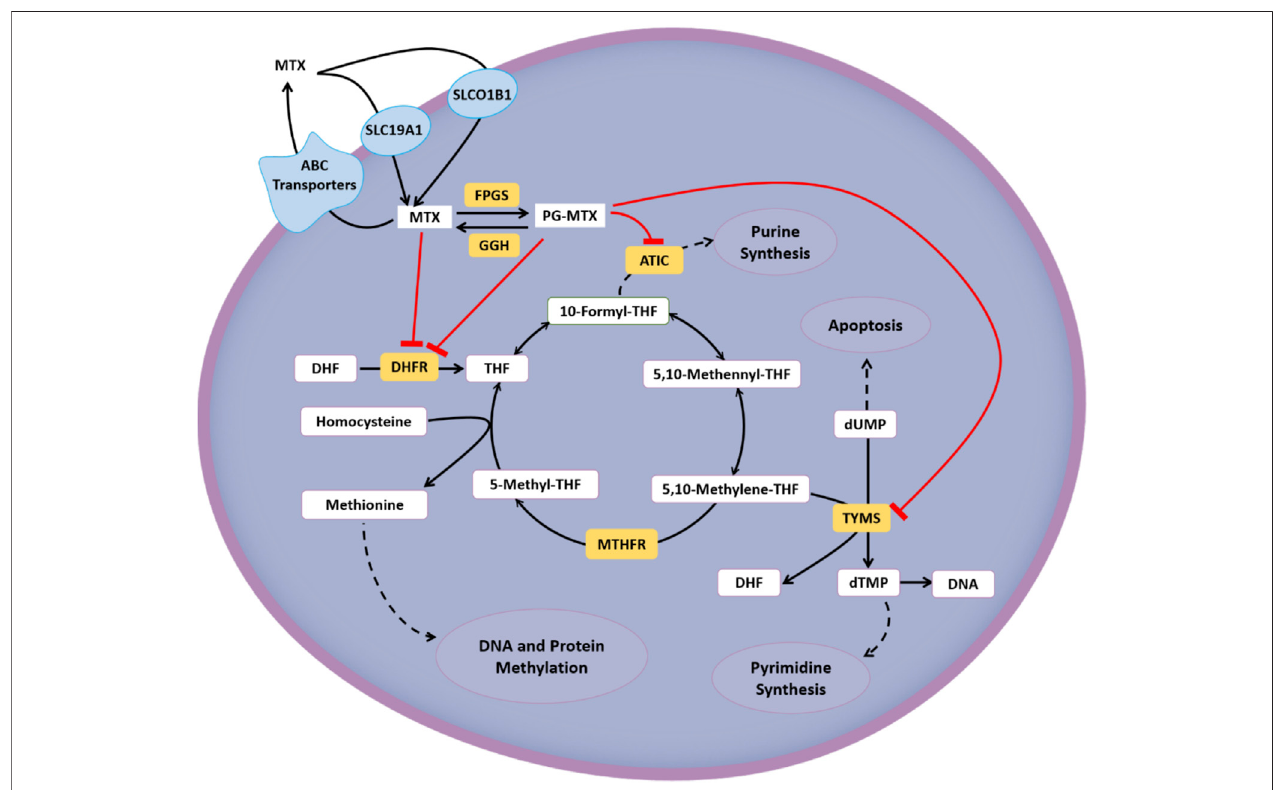
FIGURE 1 | Cellular metabolic pathway and targets of